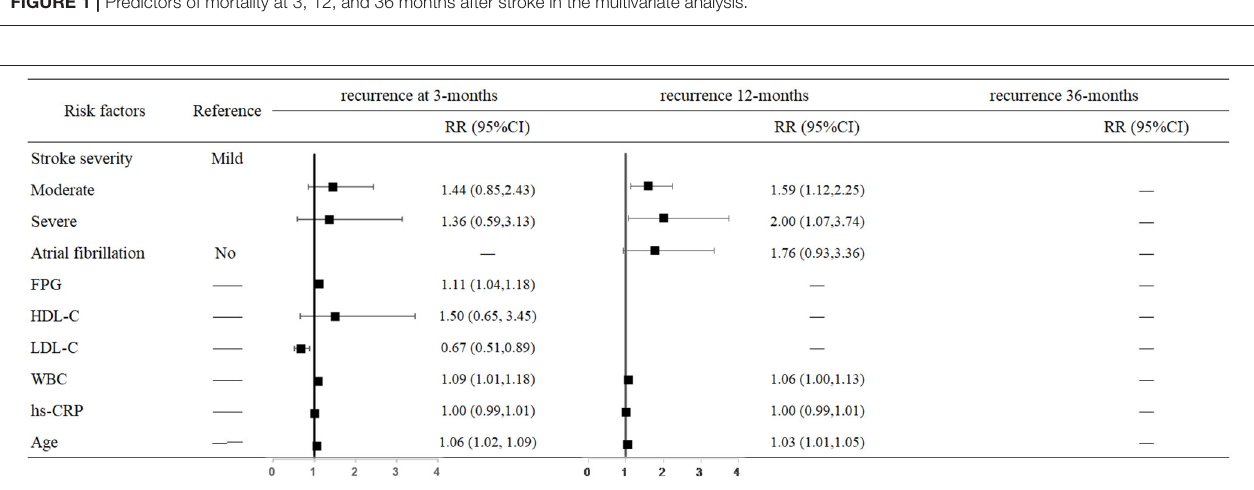
FIGURE 1 | Predictors of mortality at 3, 12, and 36 months after stroke in the multivariate analysis.